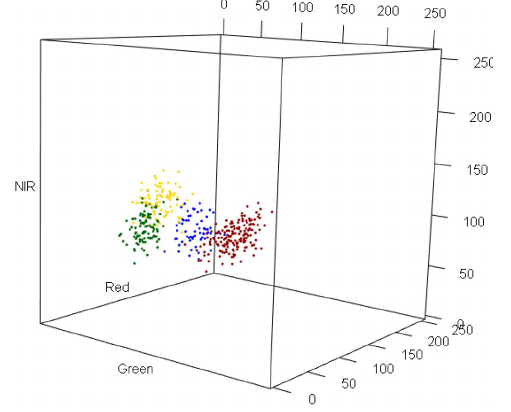
Figure 2. An exemplar demonstration of training data for the 4- class, 3-feature case.